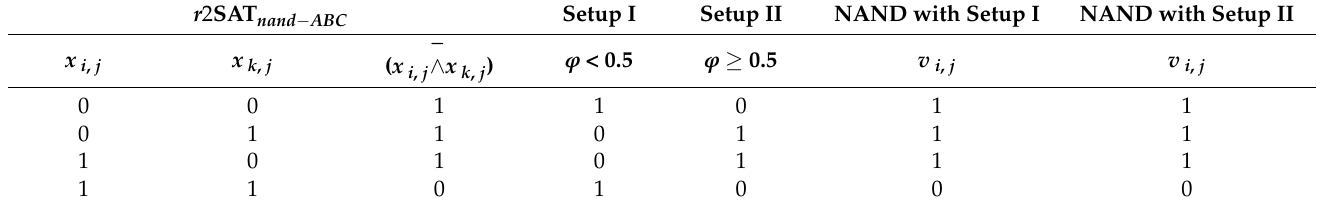
Table 15. Position update in Equation (14) with NAND logic gate operator with equal probability (unbiased ϕ ).